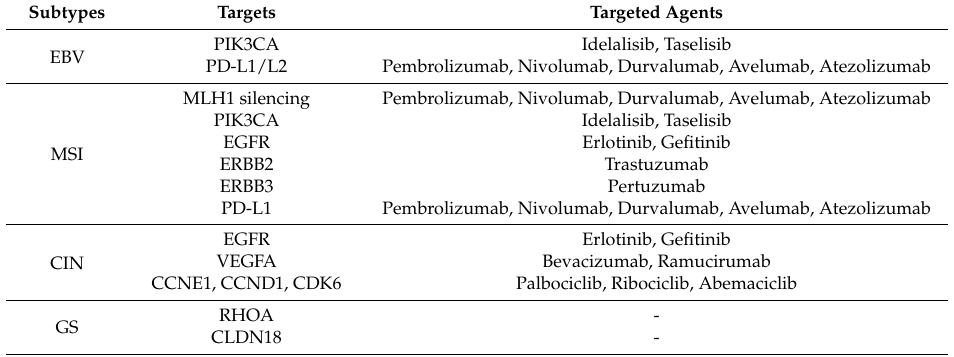
Table 2. TCGA molecular subtypes of gastric carcinoma and the associated targets and targeted agents.